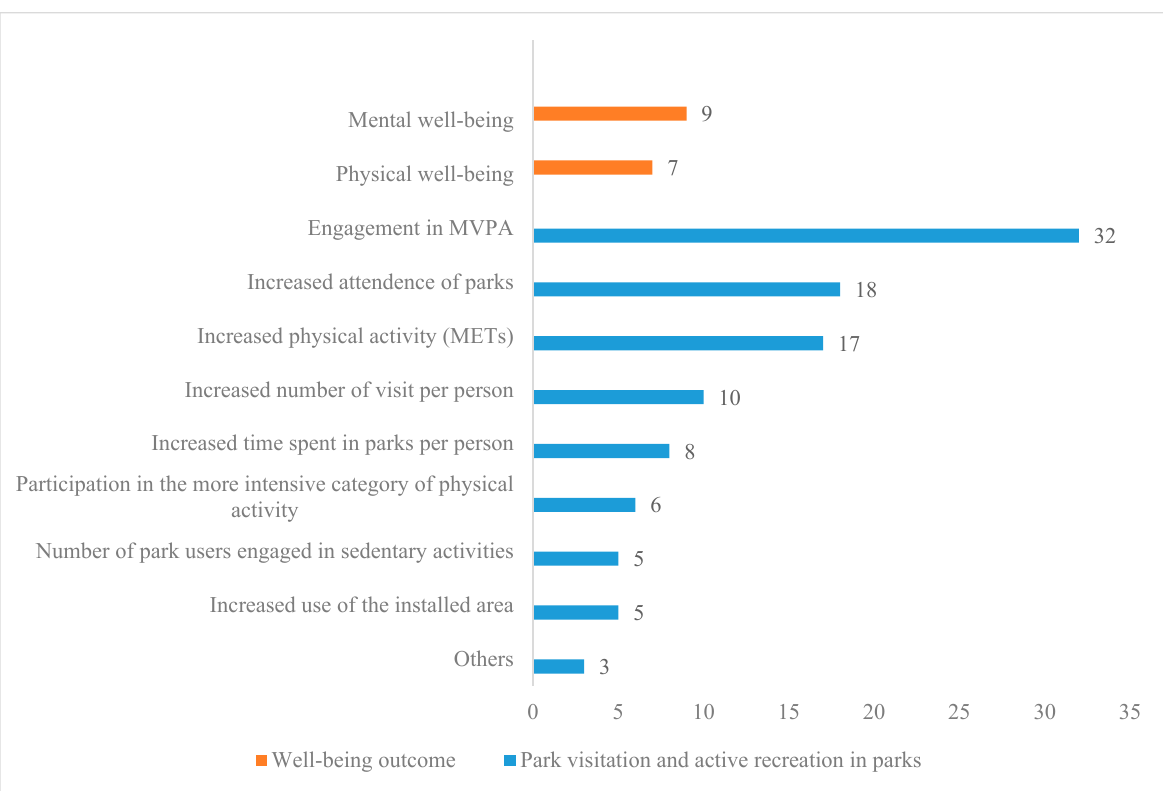
Figure 5. Numbers of studies by outcome measures. Note: Not all studies of well-being outcomes are included; only those measuring active recreation in parks are counted. METs (Metabolic Equivalents) are commonly used to measure the intensity of physical activities. It is the ratio of a person’s working metabolic rate relative to resting metabolic rate. Source: Authors’ own multi-database literature search.